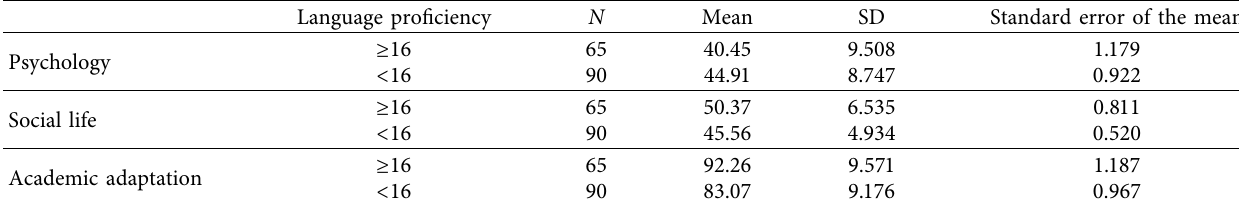
Table 4: Set of statistics of the adaptation in psychology, life, and